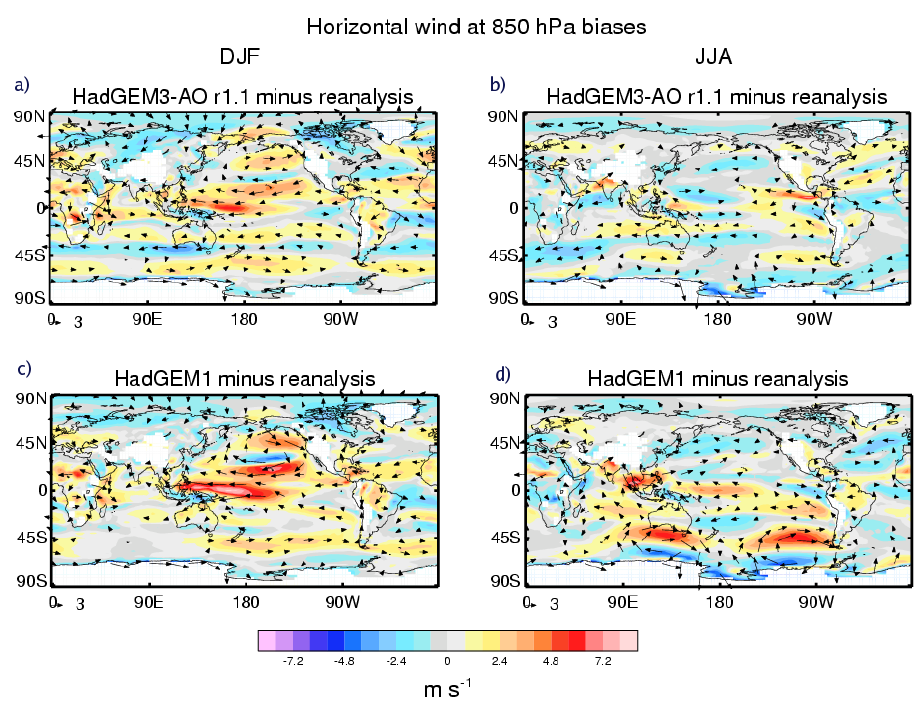
Figure 10: Biases in horizontal wind climatology (relative to ERA40 climatology shown in figure (cid:4)(cid:2) Fig. 10. Biases in horizontal wind climatology (relative to ERA40 climatology shown in Fig. 9) for HadGEM1 ( a–b ) and HadGEM3 r1.1 9) for HadGEM1 (a-b) and HadGEM3 r1.1 (c-d) for the seasons December to February (plots a (cid:5)(cid:2) ( c–d ) for the seasons December to February (plots a and c ) and June to August (plots b and d & c) and June to August (plots b & d). (cid:6)(cid:2) (cid:7)(cid:2)